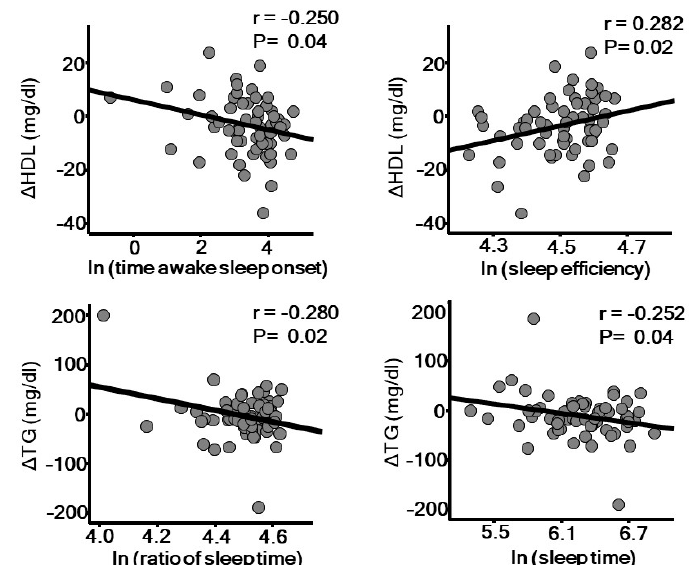
Figure 3. Sleep quality assessed by actigraphy is significantly associated with annual changes of high density lipoprotein (HDL) cholesterol and triglyceride level. The parameters of sleep quality were natural logarithm-transformed (ln) to achieve a normal distribution. r : Pearson’s correlation coefficient.